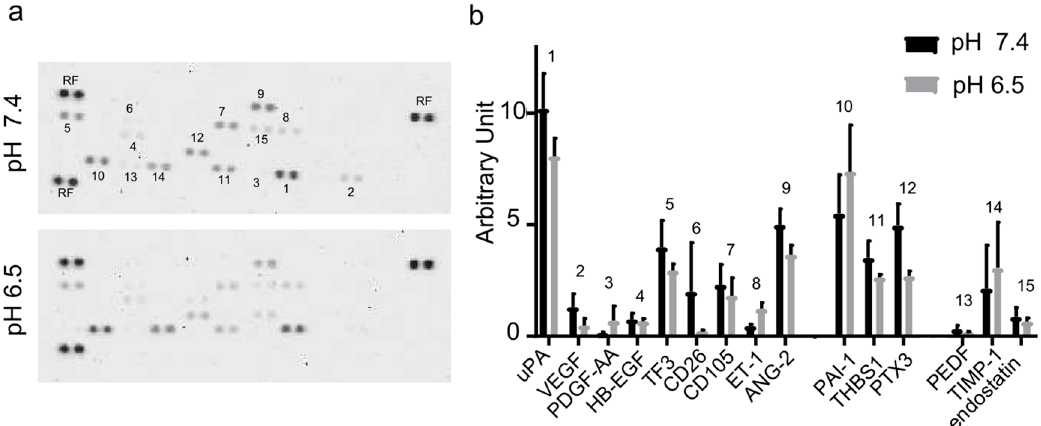
Figure 4. EVs cargo: angiogenesis-related proteins. ( a ) Representative images of the positive spots associated with the angiogenesis-related proteins detected by the human angiogenesis array (RF: reference spot) ( b ) Densitometric quantification of angiogenesis array signal (mean ± SE, Mann–Whitney test). The experiment was performed two times in duplicate. (1–9: pro-angiogenic factors; 10–12: pro/anti-angiogenic factors; 13–15: anti-angiogenic factors).